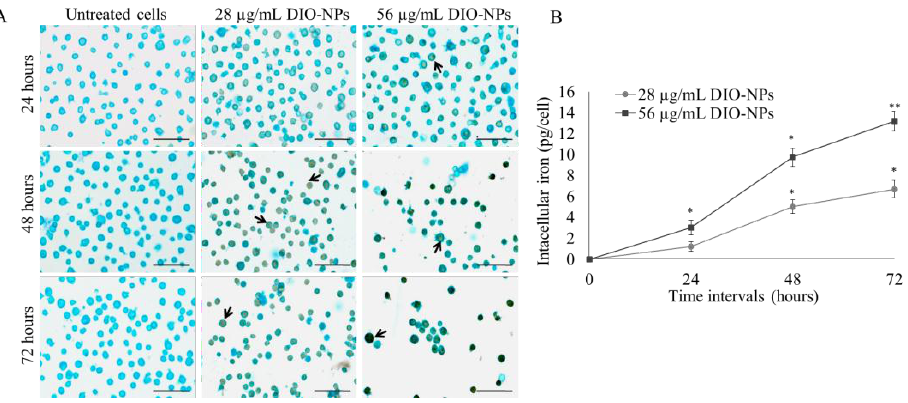
Figure 6. Quantification of intracellular iron content. ( A ) DAB-enhanced Prussian blue staining of Jurkat cells after 24 h, 48 h, and 72 h of exposure to 28 and 56 µg/mLDIO-NPs. Intracellular iron is highlighted by a brown color (black arrows), and cytoplasmin a blue color (LuxolFast Blue staining). Scale bar = 50 µm. ( B ) Iron content quantified by relaxometry. The values are expressed as means ± SD ( n = 3/experimental group). * p < 0.05 vs. control; ** p < 0.01 vs. control. Metals 2017 , 7 , 63